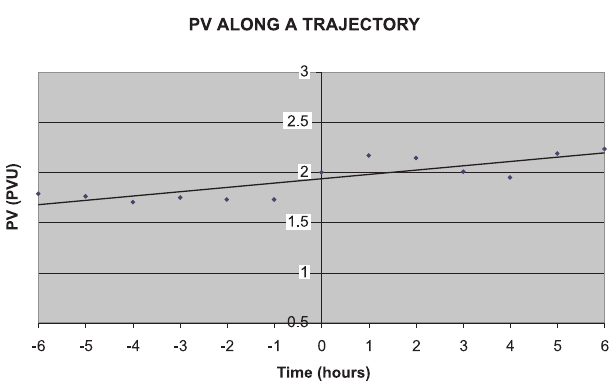
Fig. 2. Determination of the 12-hour mean d PV/ d t with a linear regression of PV versus time. The trajectory model gives output data every hour (1 PVU = 10 ) 6 K m 2 kg ) 1 s )